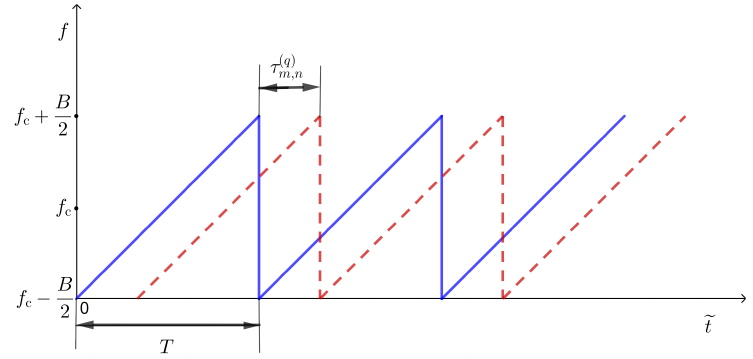
Figure 2. Transmitted chirp signal (solid blue line) and received chirp signal (dashed red